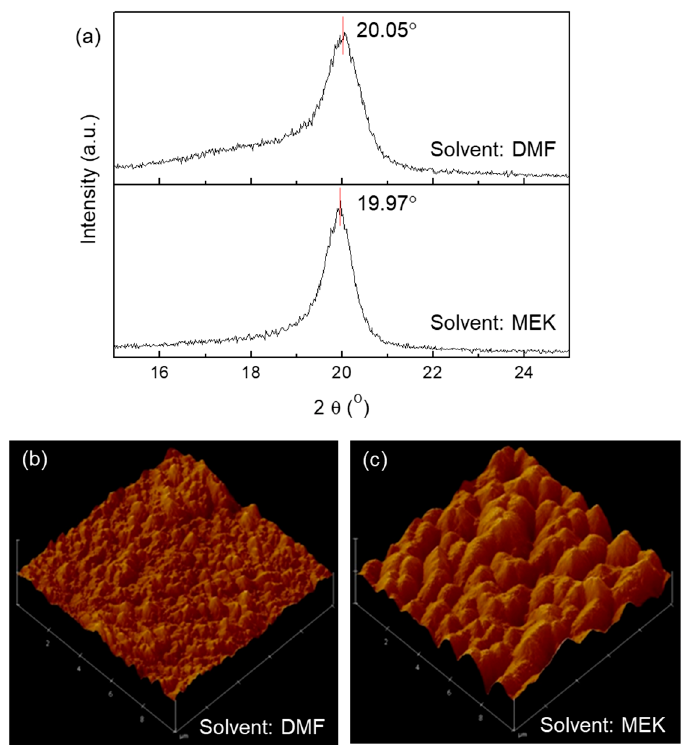
Figure 2. ( a ) XRD patterns of P(VDF-TrFE) films from DMF (top) and MEK (bottom) solvents; AFM images of P(VDF-TrFE) surfaces from ( b ) DMF and ( c ) MEK solvents.